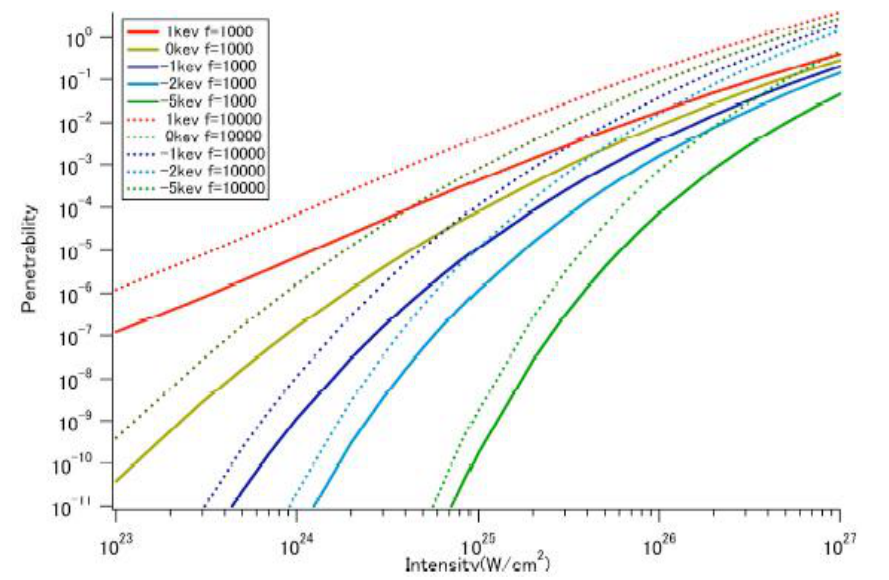
Figure 7. Calculated penetrability with laser peak